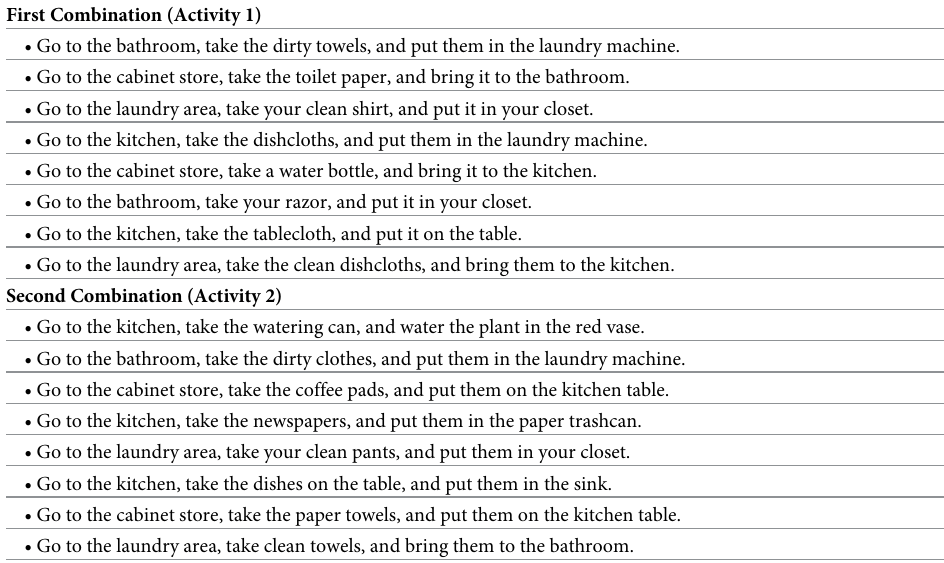
Table 2. Two combinations of eight responses considered to represent two viable